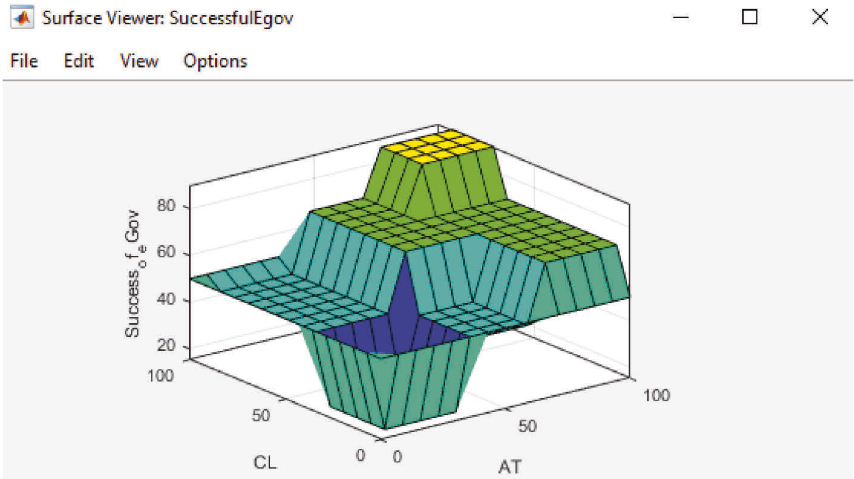
Figure 9: Three dimension of the IAT and CL with the success of